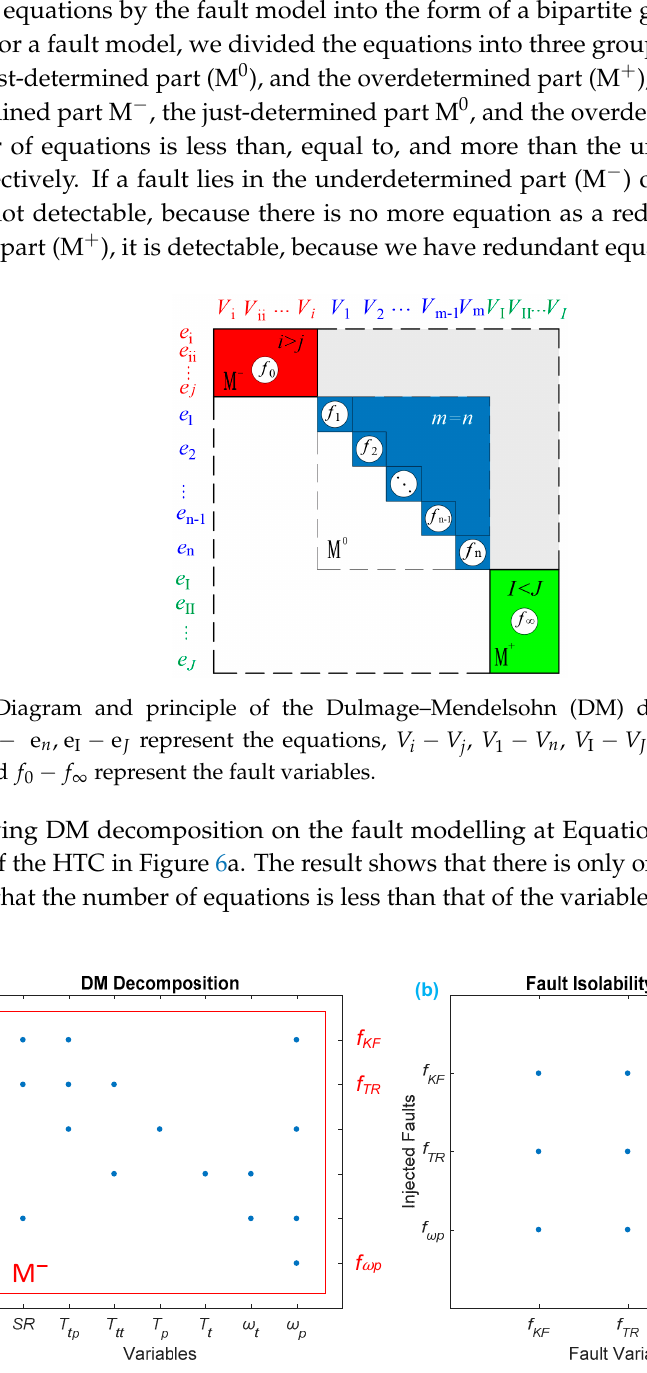
Figure 6. Fault detectability and isolability of the HTC: ( a ) DM decomposition for the HTC, where all the faults are located in the M − part, so all three faults are not detectable; ( b ) fault isolability matrix (FIM) of the HTC; “ • ” means the horizontal and longitudinal fault variables are correlated; thus, all three faults are not isolatable.